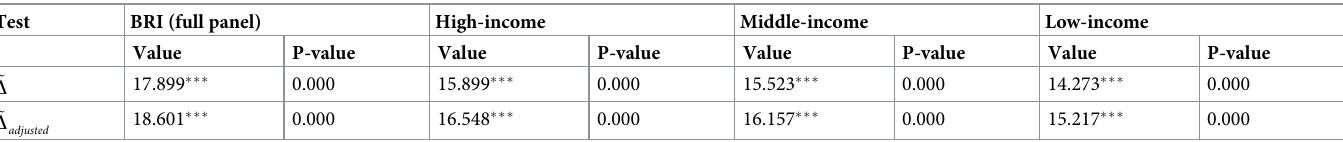
Table 2. Results of slope homogeneity test.